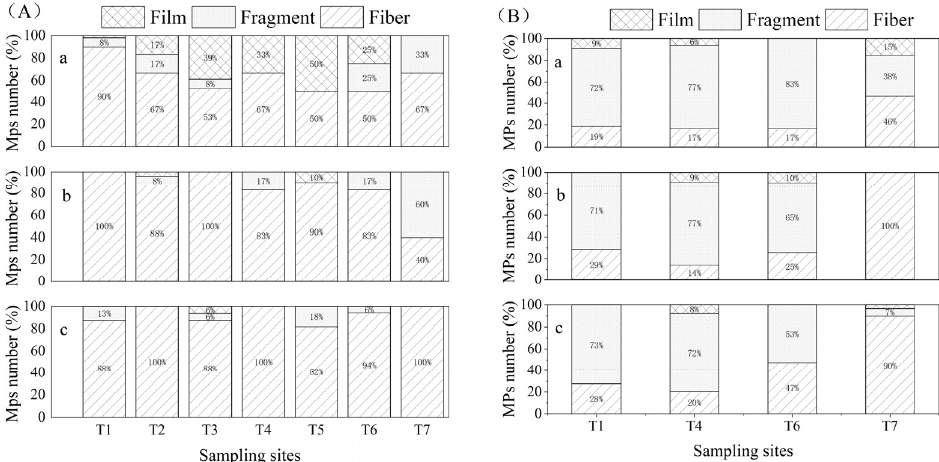
Figure 4. The proportion of microplastic shapes in different seasons. ( A ) denotes a water sample, while ( B ) represents a sediment sample. Proportions of various microplastic shapes in wet, typhoon, and dry seasons are represented by a, b, and c, respectively.